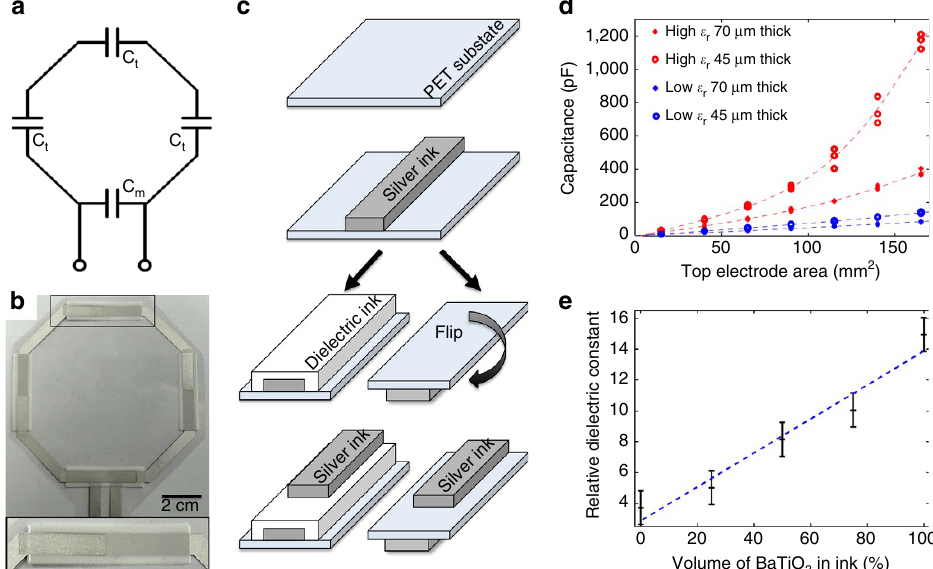
Figure 2 | Fabrication method and characterization of printed receive coils. ( a ) Schematic of a printed coil showing tuning, C t , and matching, C m , capacitors. ( b ) Photograph of a printed coil. Inset highlights top-down view of printed capacitor. ( c ) Coil printing process flow showing two optional possible processes: printed dielectric or using the substrate as a dielectric. ( d ) Dependence of capacitance with top electrode area, dielectric thickness and ink composition. ( e ) Relative dielectric constant, measured at 127MHz, as the volume of barium titanate in the ink is increased. High dielectric constant is achieved with barium titanate ink, while low dielectric constant is achieved with ultraviolet-curable ink. Error bars show standard